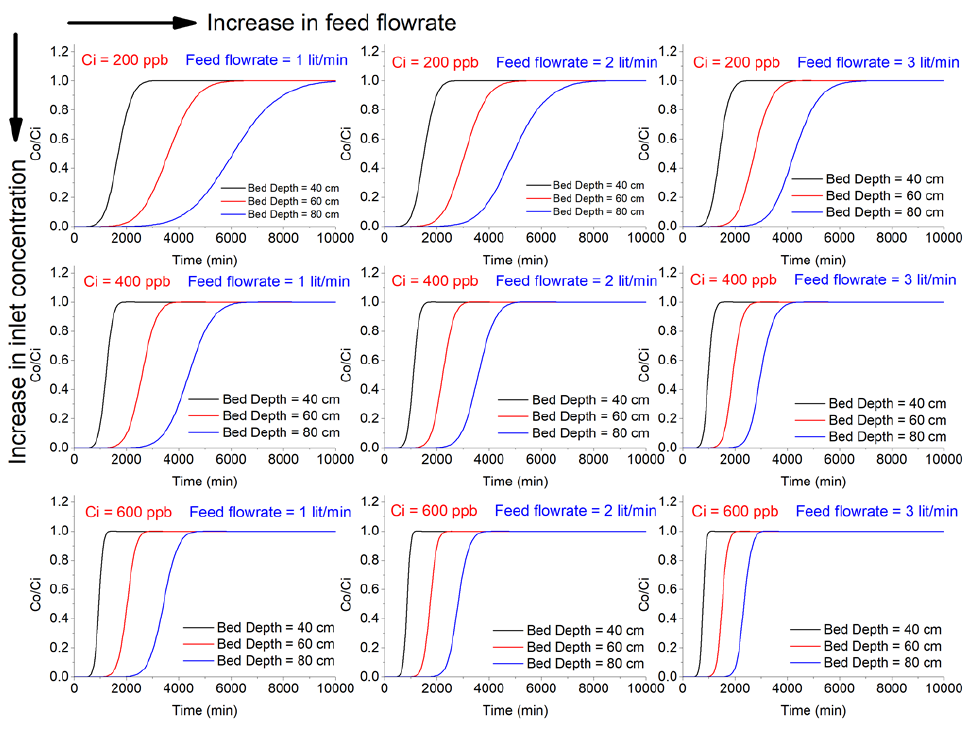
Figure 5. Effects of the bed depth, the feed flow rate, and the initial arsenic concentration. Table 4. Factors design matrix and